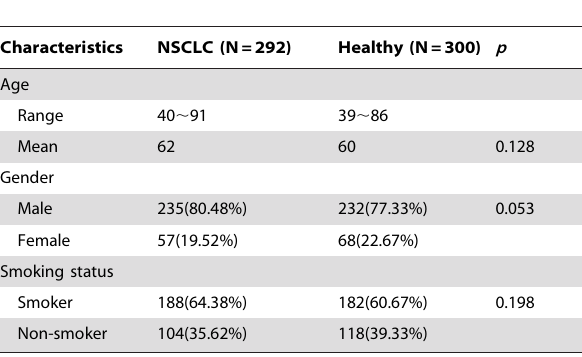
Table 1. Clinical characteristics and distribution of sera APE1- AAbs of studied